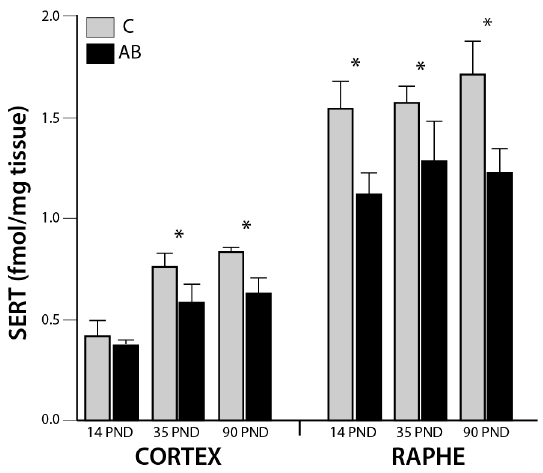
Figure 1. SERT Binding Densities. MAO inhibition with combined clorgyline and deprenyl (AB), as described in detail in the text, reduced SERT binding in the cortex (F 3,52 = 3.59, p = 0.02) and the raphe nuclei (F 3,51 = 6.07, p = 0.0015) in both a time- and treatment-dependent fashion. Significant pairwise time x treatment effects ( p < 0.05) are indicated by *. In the cortex, AB was significantly different from all other groups (post-hoc p < 0.05); in raphe, AB was significantly different from C and A, and B was also significantly different from C (post-hoc p < 0.05). Six animals were examined for each treatment and each time point; error bars S.E.M.